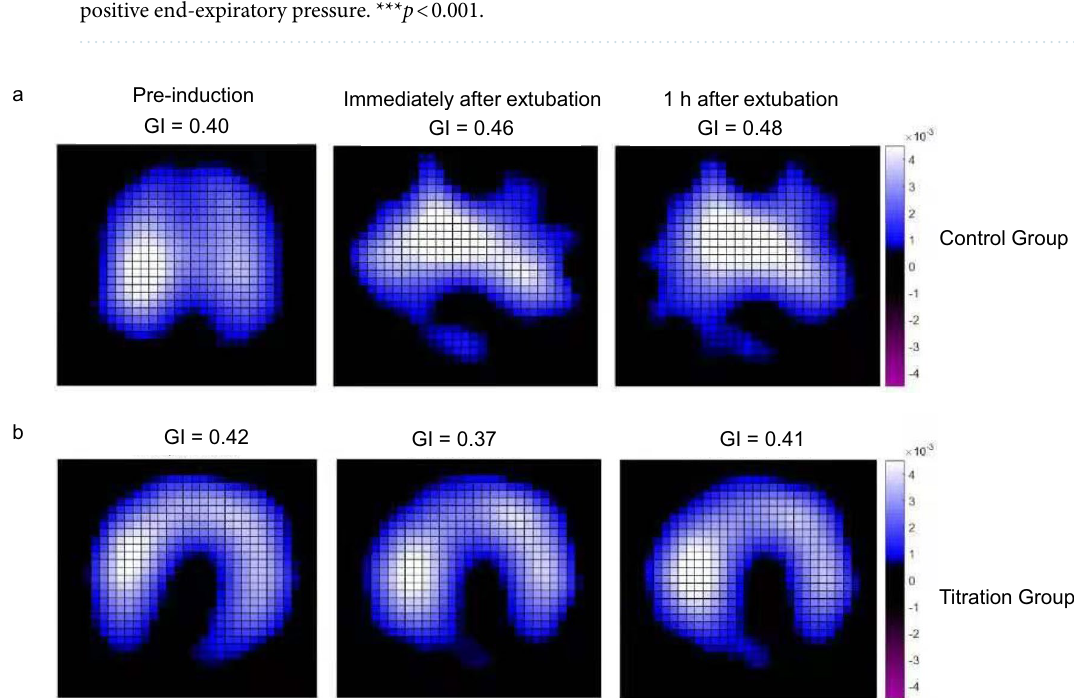
Figure 3. Representative images showing tidal variation measured by electrical impedance tomography at different time points for patients from ( a ) the control group and ( b ) the titration group. GI the global inhomogeneity